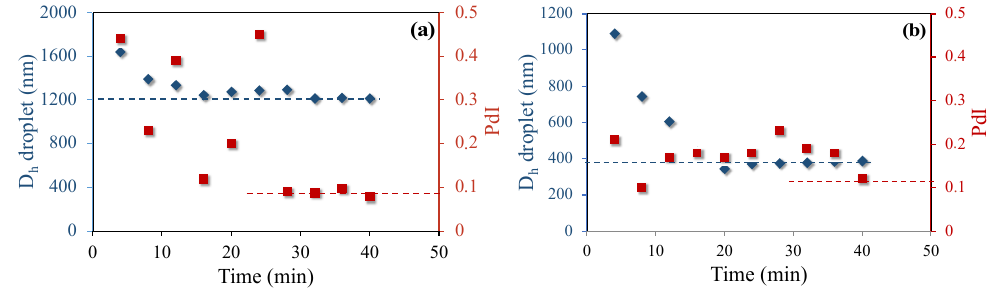
Figure 2. Progress of dynamic light scattering (DLS) droplet diameter over time for styrene miniemulsions obtained using the rotor–stator mixer operating at a rotational speed of 3000 rpm with different surfactants: ( a ) 1.5 wt% of SDS and ( b ) 1.5 wt% of in situ generated K-oleate, using HD as the hydrophobe.